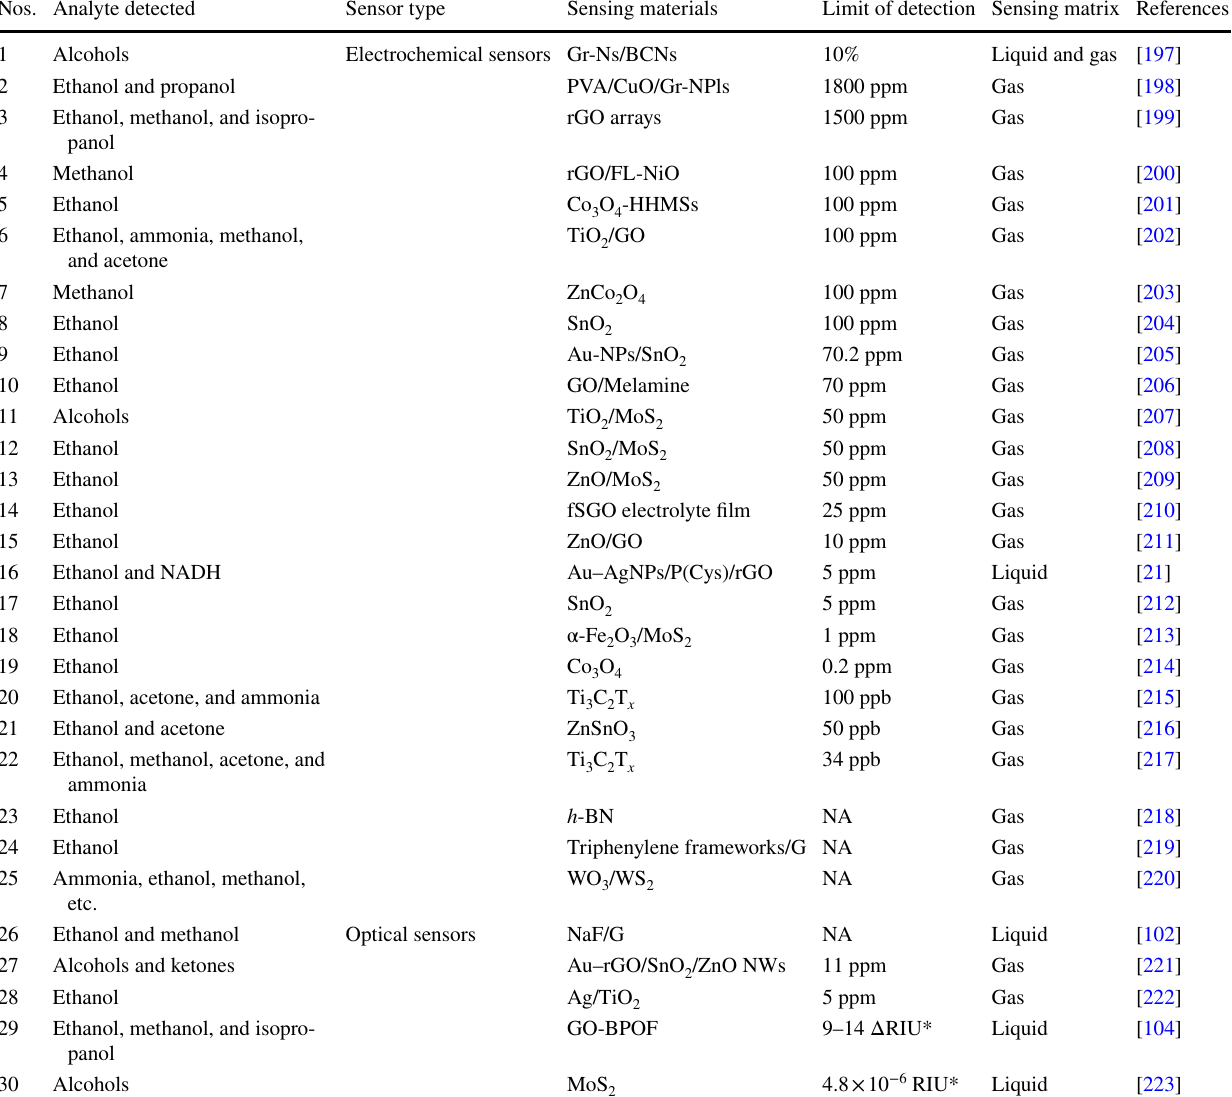
Table 1 Analytical parameters of 2D-based alcohol sensors and biosensors, sorted by LoD and type